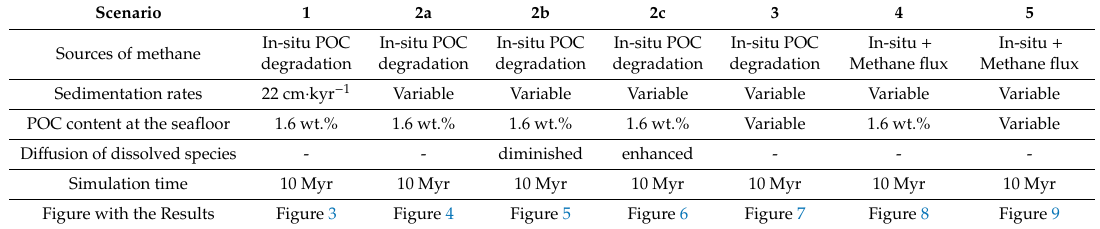
Table 5. Summary of modeling scenarios presented in the